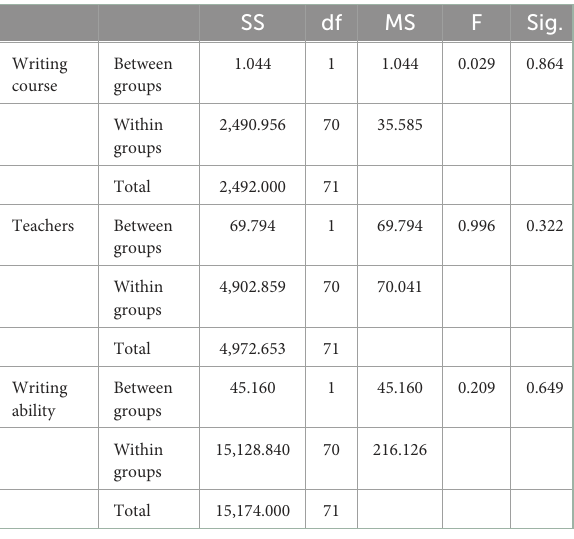
TABLE 7 One-way ANOVA results based on three anxiety